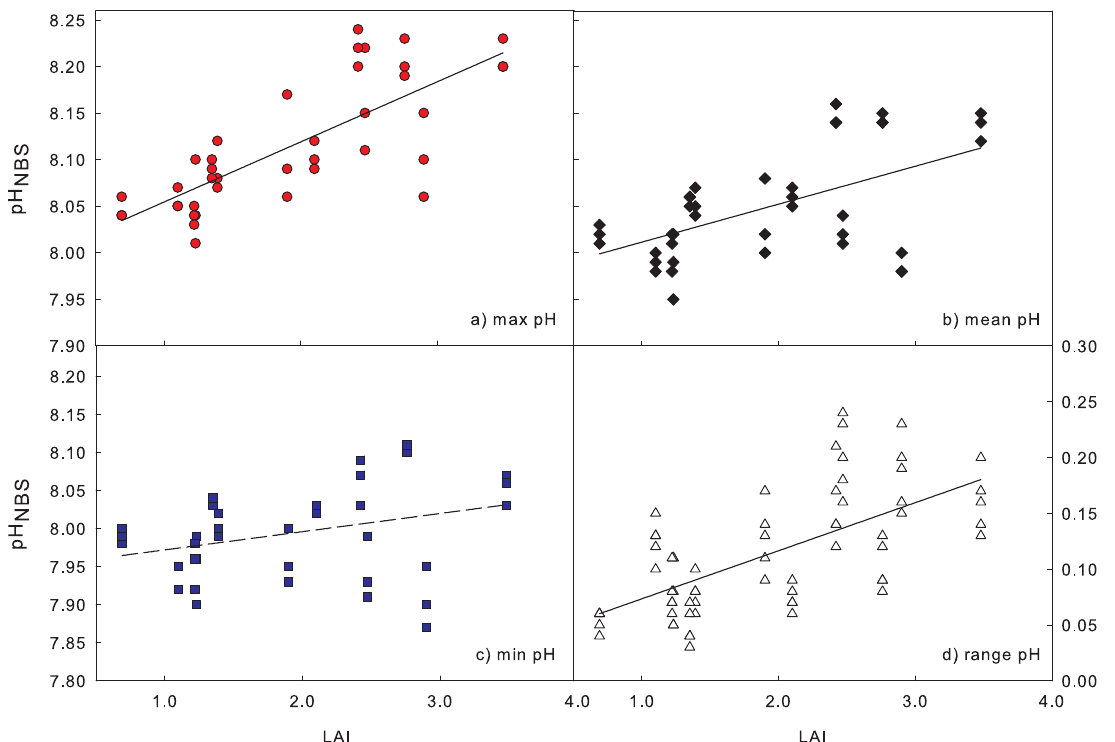
Fig. 3. The relationships between leaf area index (LAI) and (a) max, (b) mean, (c) min pH and (d) pH range. Non-significant relationships are dotted lines. Linear regressions are described for maximum pH (red circles) as 0.06 LAI + 7.99 ( r 2 = 0 . 60), Mean pH (black diamonds) by 0.04 LAI + 7.97, ( r 2 = 0 . 31), Minimum pH are blue squares while the range of pH (right y axis) are white triangles with linear regression 0.04 LAI + 0.03 ( r 2 = 0 .